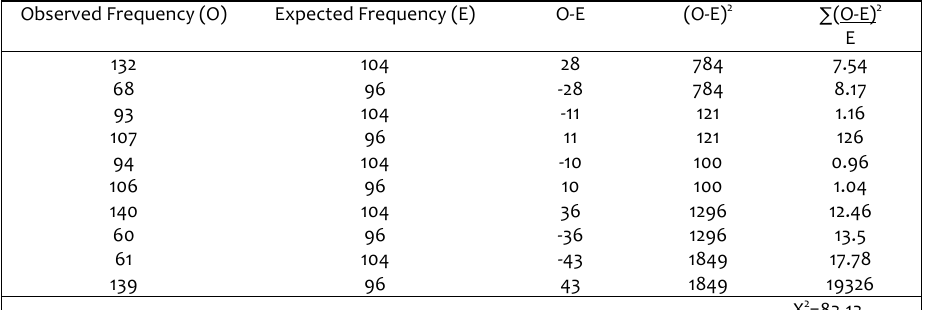
Figure 7: Calculation of chi ‐ square for hypothesis